Question: Provide a one-line summary of what is displayed.
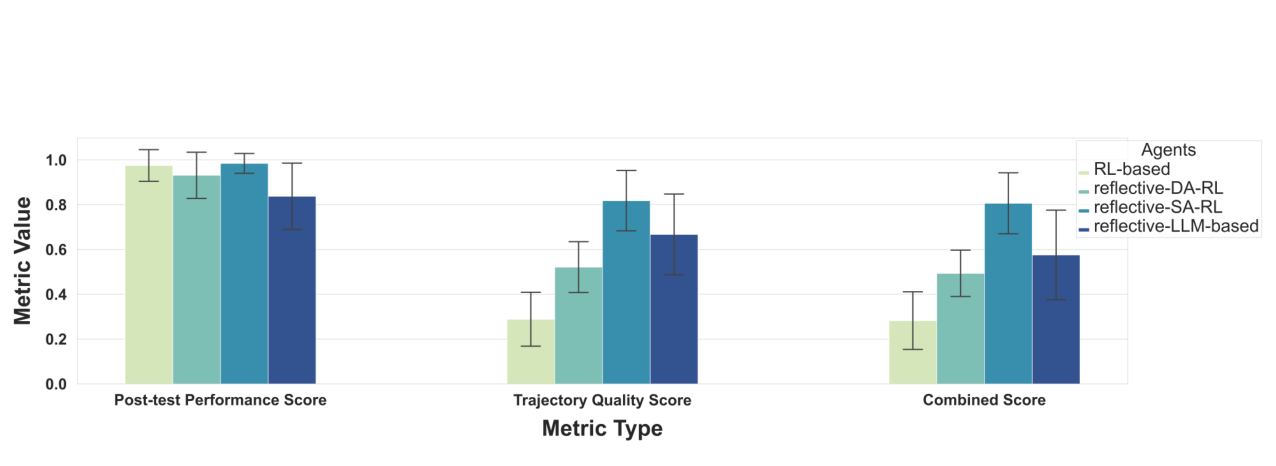
Answer: Agent Performance on PharmaSimText. Post-test Performance Score (left), Trajectory Quality Score (middle), and Combined Score (right) of the RL-based agent, the reflective-DA-RL agent, the reflective-SA-RL agent, and the reflective- LLM-based agent. In the SA-RL agent, the LLM suggests k actions at each step for the RL agent to choose from. In the DA-RL agent, the LLM selects an action from the top-k choices provided by the RL agent. Scores are averaged across all patients in PharmaSimText.